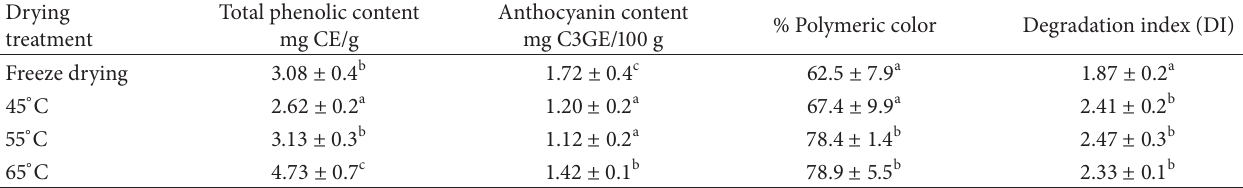
Table 4: Total phenolic content, anthocyanin content, % polymeric color, and degradation index (DI) in dehydrated half cut figs.